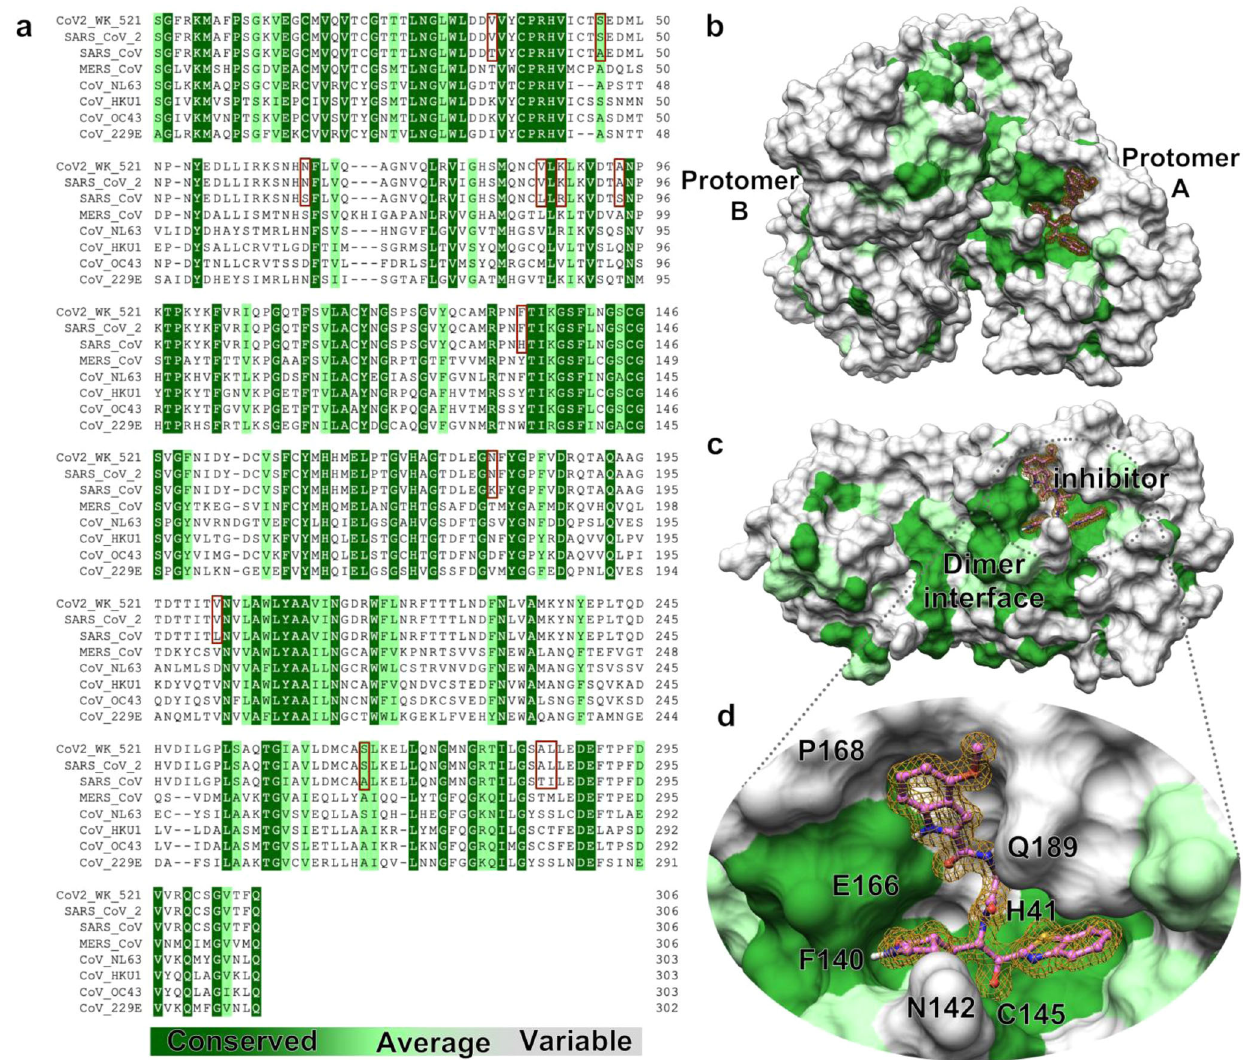
Fig. 1 Human coronaviruses Main proteases (M pro s) are highly conserved around the dimer interface and ligand binding groove. a Amino acid sequence alignment of main proteases (M pro s) of eight human coronaviruses are shown. Identical amino acids are indicated in dark green; moderately conserved residues in light green and variable amino acids in light gray. The sequence of M pro of SARS-CoV-2 WK-521 used in the present study is completely identical to that of SARS-CoV-2 (PDB:6LU7) and shares 96% identity with the SARS-CoV (PDB: 2AMQ). The 12 amino acid residues that differ between the sequence of SARS-CoV ’ s M pro and that of SARS-CoV-2 WK-521 are highlighted in pink. Other less conserved sequences are from M pro s of MERS-CoV (PDB: 5C3N), CoV-NL63 (PDB: 5GWY), CoV-HKU1 (PDB: 3D23), CoV-229E (PDB: 2ZU2) and CoV-OC43 (Uniprot: P0C6X6). Sequence alignment was performed using Multiple Align Show (http://www.bioinformatics.org/SMS/multi_align.html). b Conservation of each residue is mapped onto the surface of M pro structure based on the sequence alignment shown in ( a ). c While M pro s exhibit a high sequence conservation around the dimer interface in the center part of each protomer, the external part of each protomer shows high variability. d Omitted electron density (2Fo − Fc) of 5h, contoured at the 1 σ level is shown inside the binding groove. 5h targets mainly a conserved